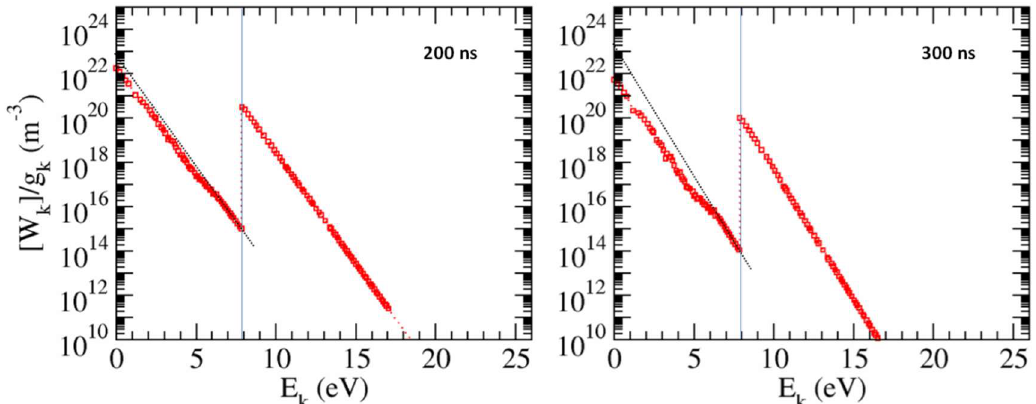
Figure 12. Same as Figure 11, but with an argon gas at 10 𝑃𝑎 . The second ionization limit is not displayed since the corresponding number densities are very weak. The line interpolating the excited states just below the first ionization limit is plotted to easily estimate the departure from excitation equilibrium.